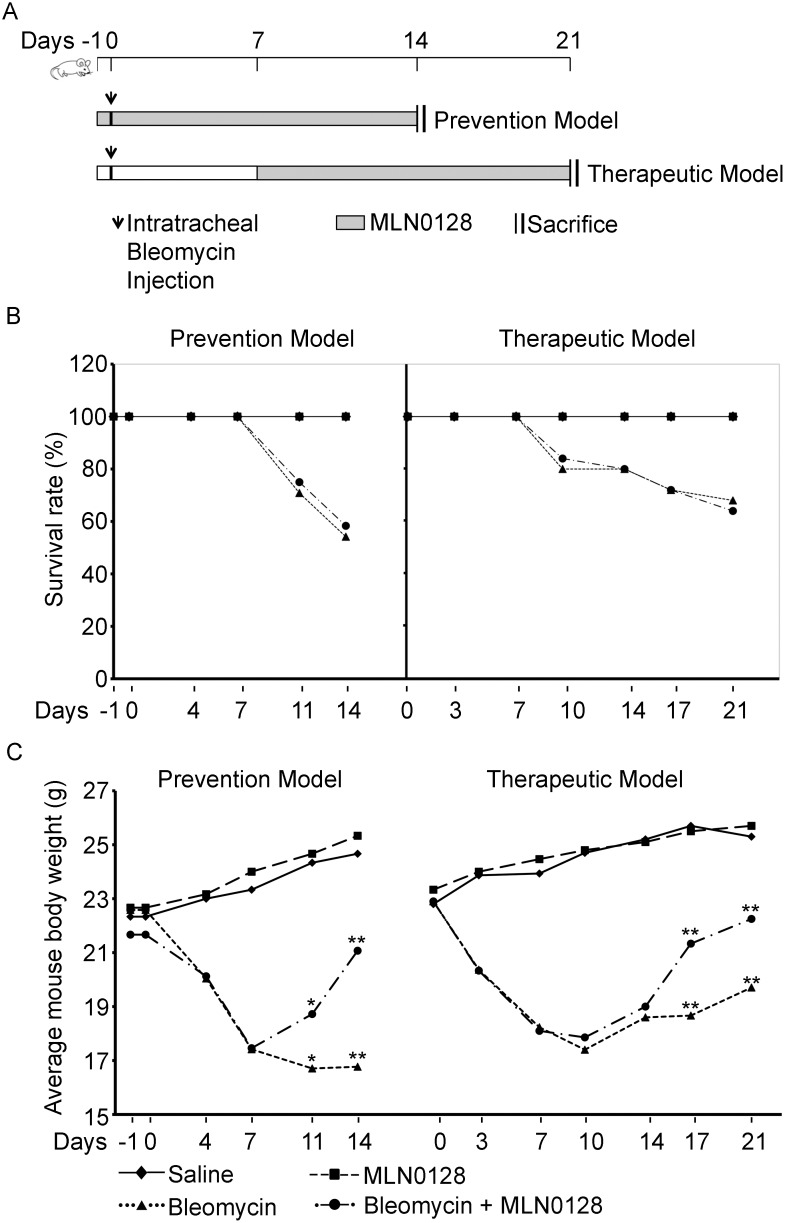
(A) Schematic of bleomycin prevention and therapeutic protocols.(B) Mouse survival rates are from four independent experiments for the prevention model (n = 3 for Saline or MLN groups and n = 6 for Bleo or Bleo + MLN groups) and from five independent experiments for the therapeutic model (n = 3 for Saline or MLN groups, n = 6 for Bleo, and n = 5 for Bleo + MLN groups). (C) Mouse body weights are from bleomycin prevention and therapeutic model experiments (*P<0.05. and **P<0.005) as in (B). Each point represents the mean body weight of mice in the respective treatment group from each experiment.